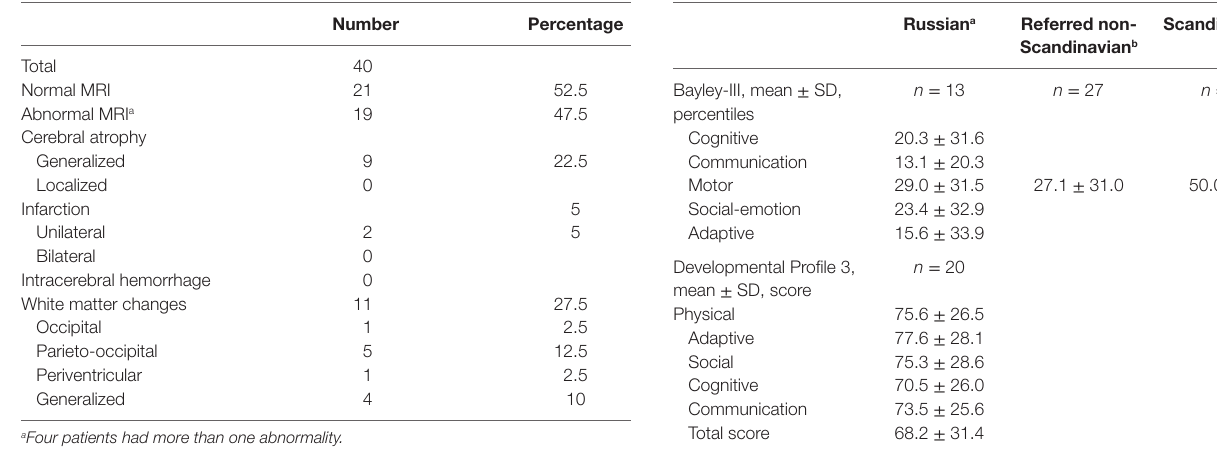
TaBle 2 | Brain magnetic resonance imaging (MRI) findings in children with congenital hyperinsulinism.